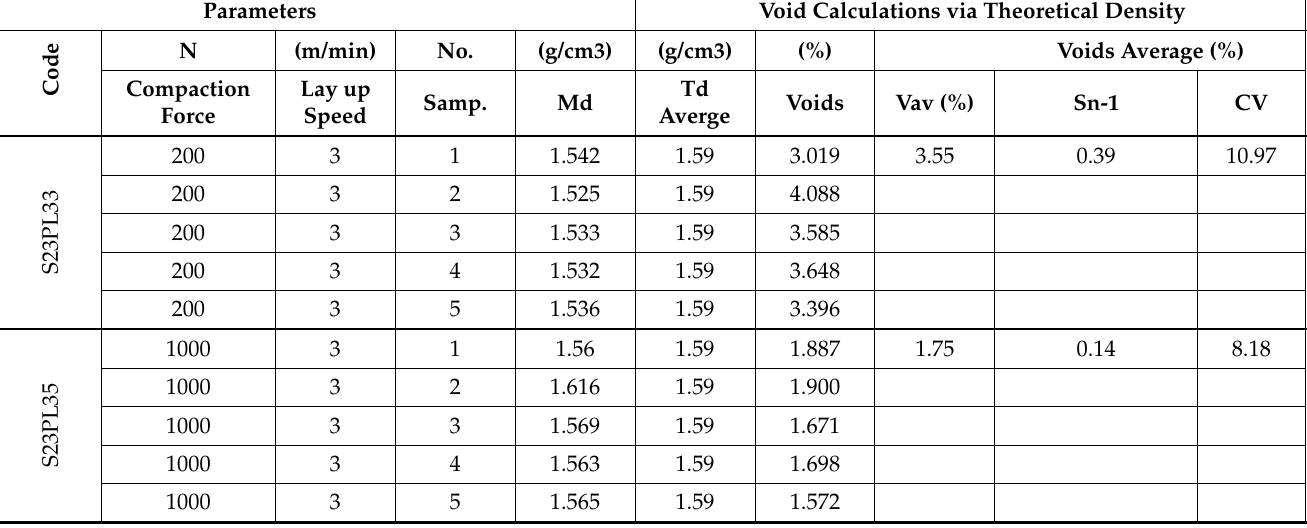
Table 3. ILSS and voids for different compaction forces, speeds and